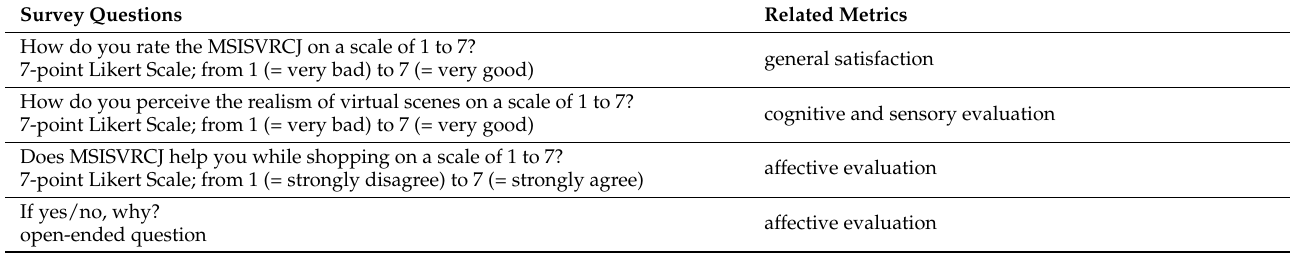
Table A1. Survey questions designed to evaluate the